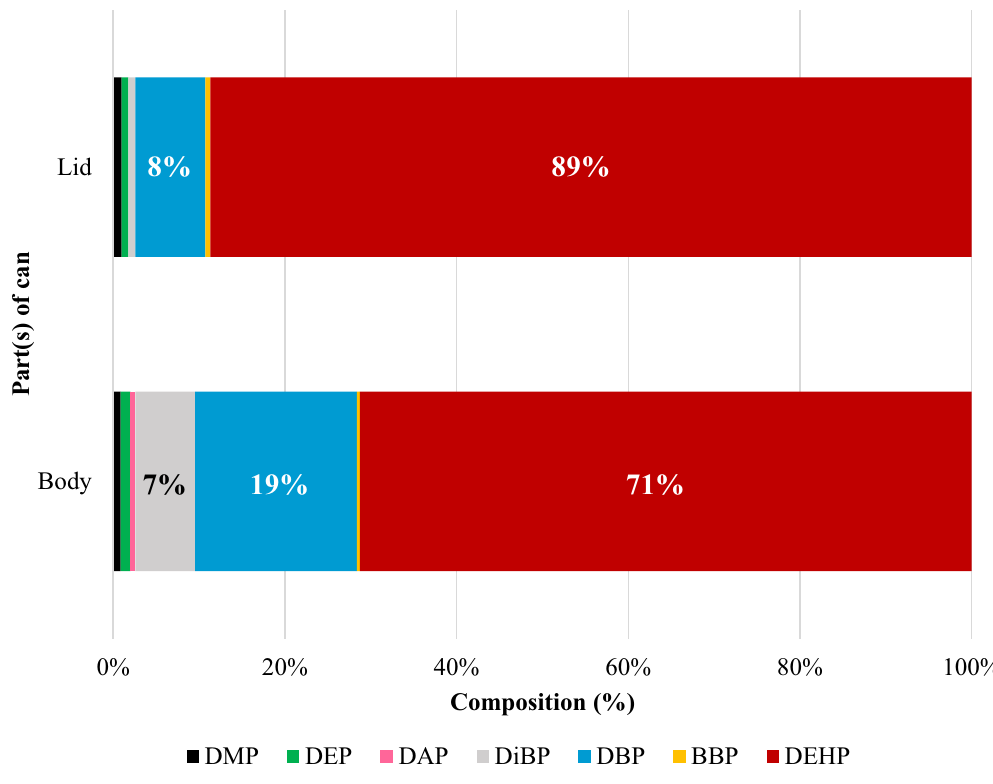
Figure 4. Composition of phthalate additives concentrations in body and lid of beer